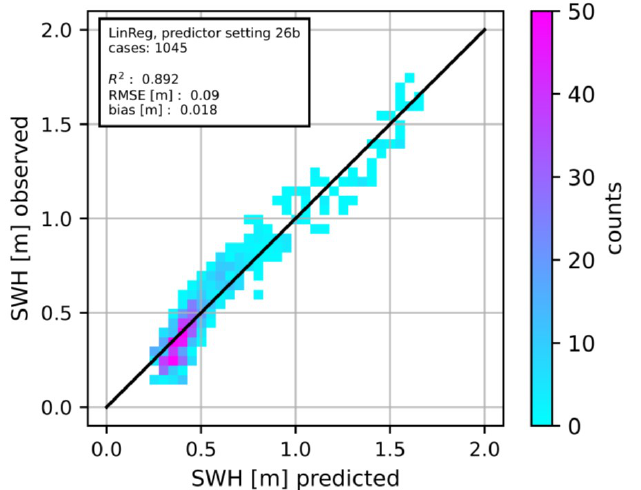
Figure 14. Validation of the GNSS-based SWH predictions against SWH measurements made with the ADCP sensor at